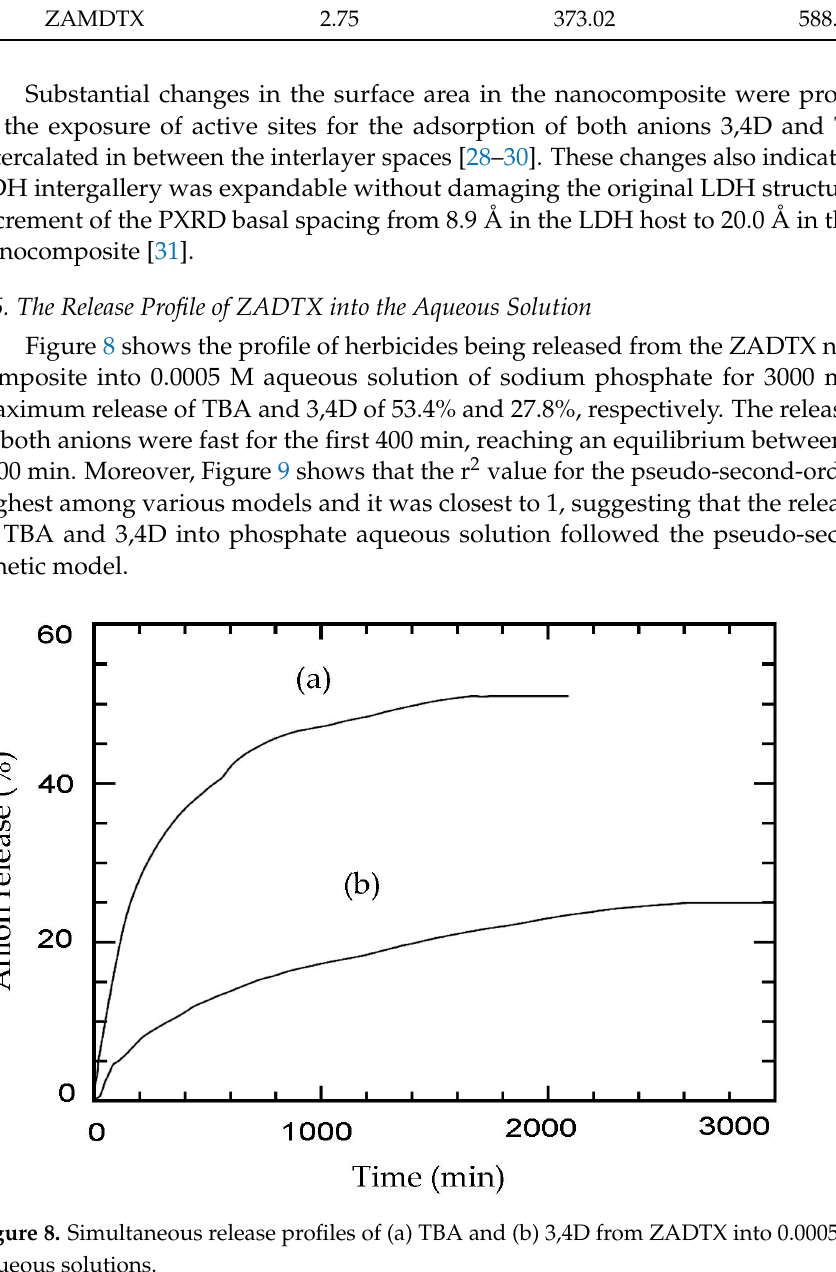
Figure 9. Fitting the release of 3,4D ( a ) and TBA ( b ) from ZADTX nanocomposite to the zeroth- order, first-order, pseudo-second-order and parabolic diffusion kinetics models.